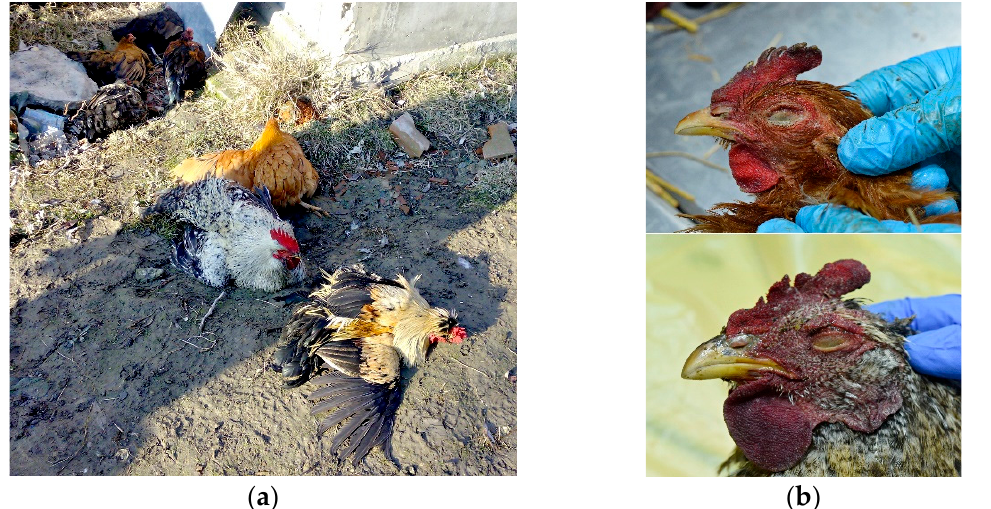
Figure 1. ( a ) Clinical signs of H5N8 avian influenza virus infection in chickens—ataxia and leg paralysis. ( b ) Cyanosis of comb and wattle in H5N8-infected chicken (upper photo) and H5N1-infected chicken (lower photo).